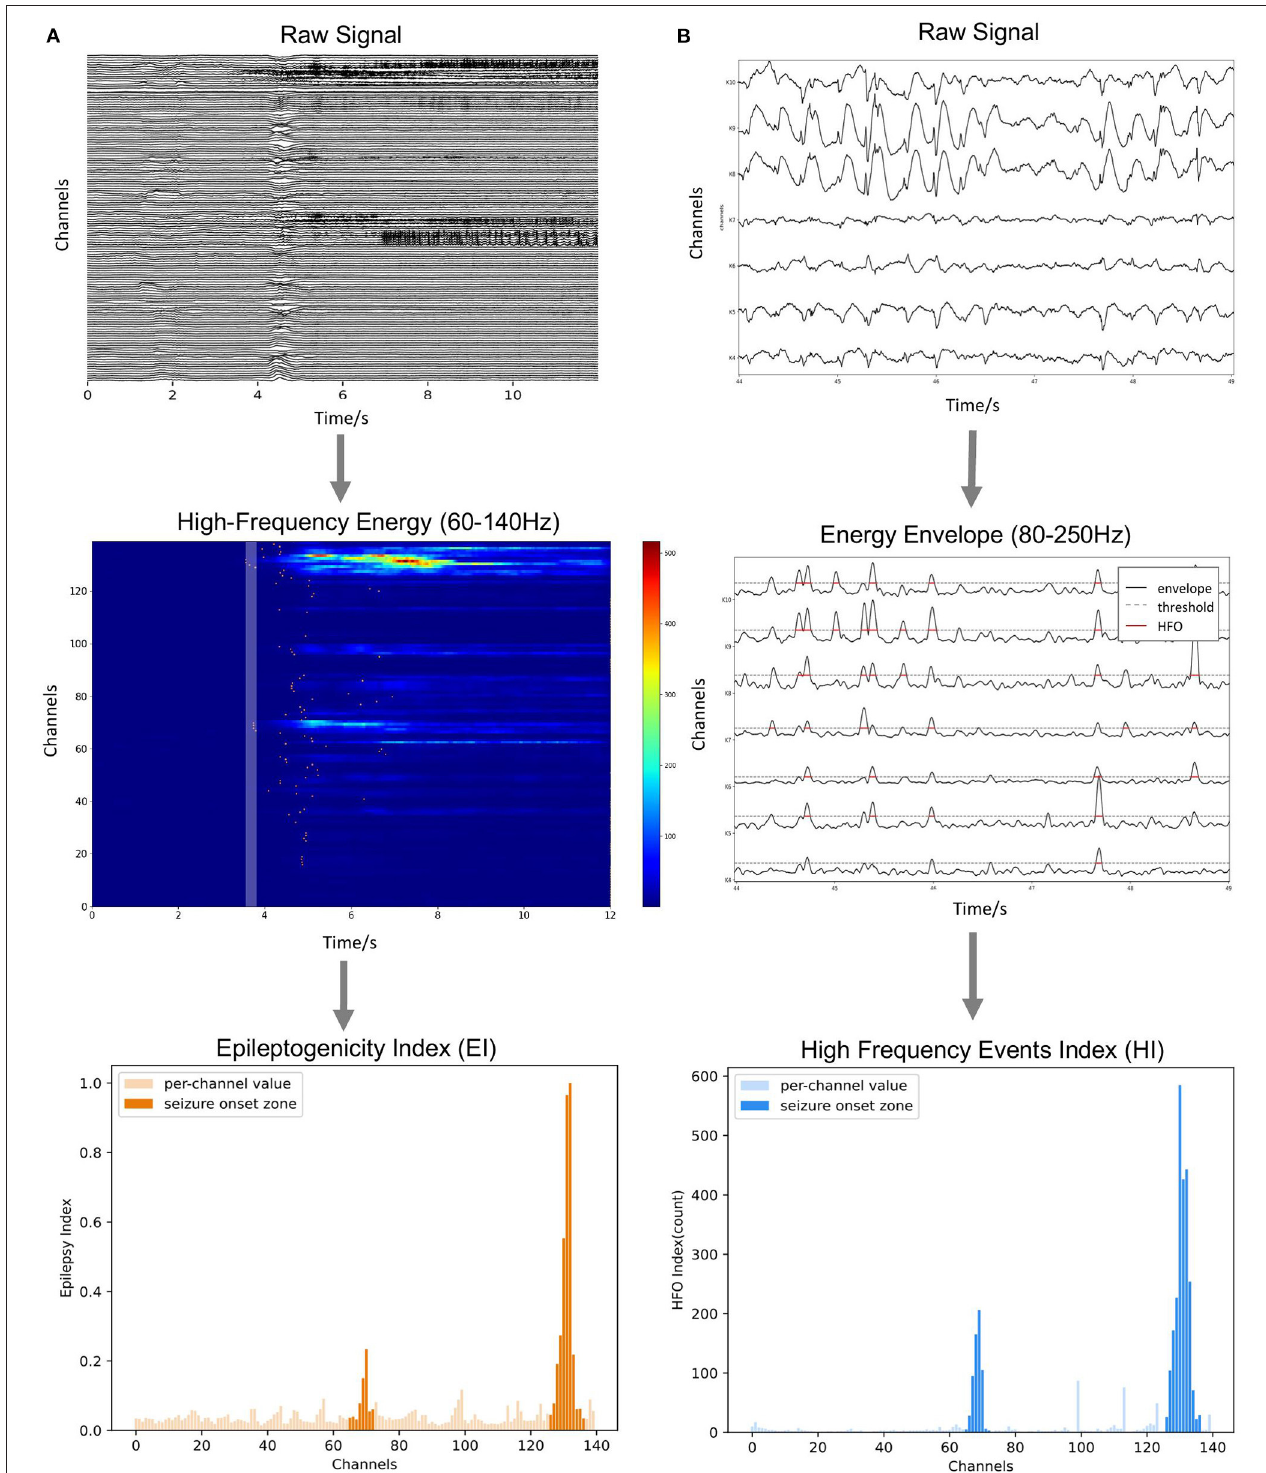
FIGURE 6 | Methods of ictal and interictal SEEG data analysis. (A) Onset timing order and energy strength during the initial stage of seizures are sorted to calculate the Epileptogenicity Index (EI). (B) Numbers of over-threshold high-frequency events are counted as High-Frequency Events Index (HI).